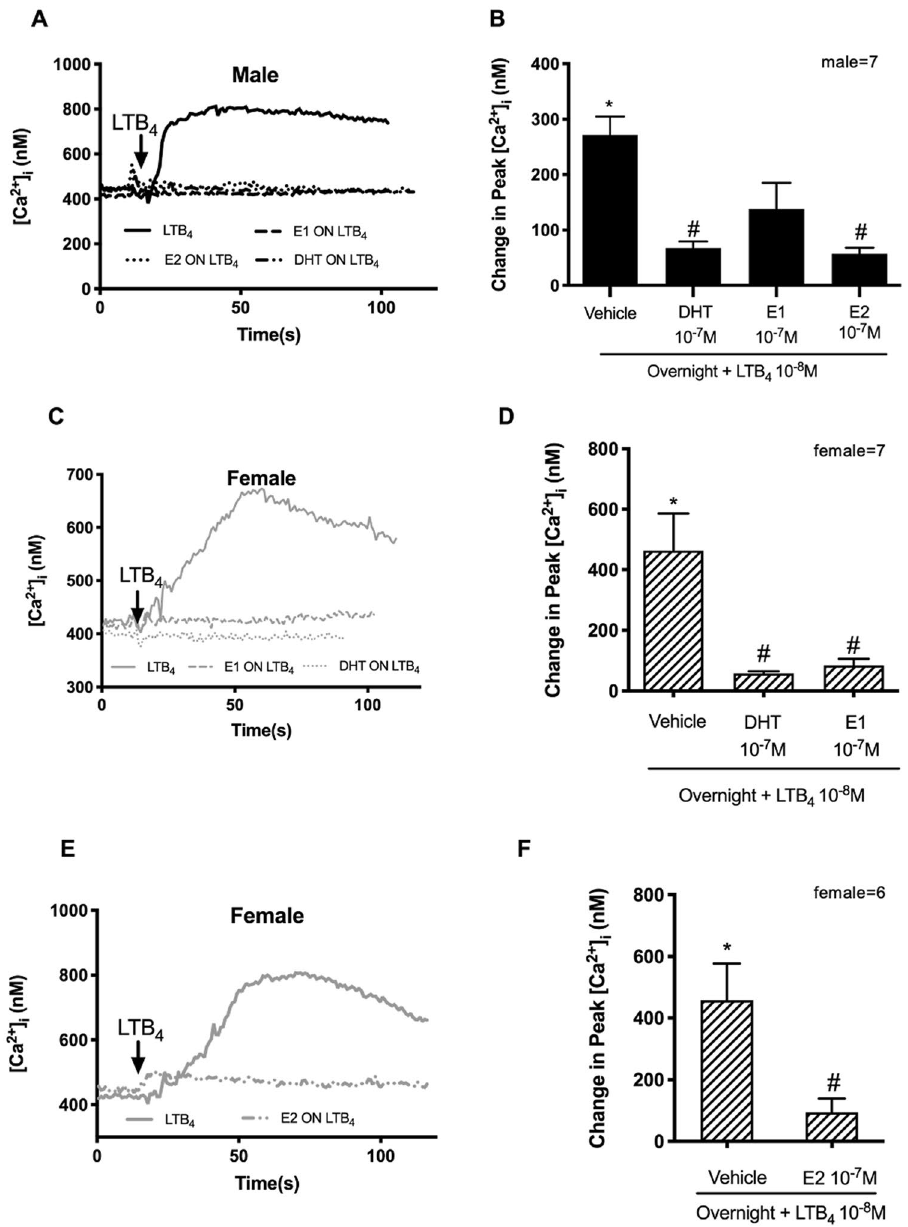
Figure 6. Overnight treatment with sex hormones inhibits the Ca 2+ response from human conjunctival goblet cells cultured from male and female cells to the inflammatory mediator LTB 4 . Cultured goblet cells from male and female conjunctiva were treated with DHT, E1 or E2 (10 −7 M) or vehicle overnight prior to addition LTB 4 (10 −8 M). [Ca 2+ ] i was measured by fura2 assay. The average [Ca 2+ ] i level over time was shown in ( A , C and E ); Change in peak [Ca 2+ ] i was calculated and shown in ( B , D and F ). Data are mean ± SEM. Number of individuals for each experiment are marked in graphs. Black lines and solid bars indicate data from male cells. Grey lines and slash-patterned bars indicate data from female cells. *Significance difference from basal. # Significance difference between males and